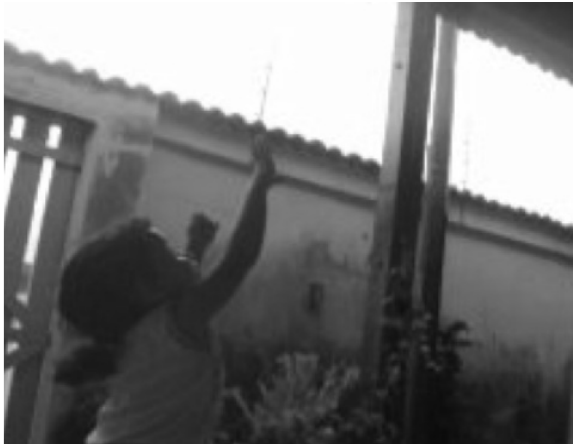
Figura 6. Criança tentando alcançar um sino de vento sinalizando a função de uma